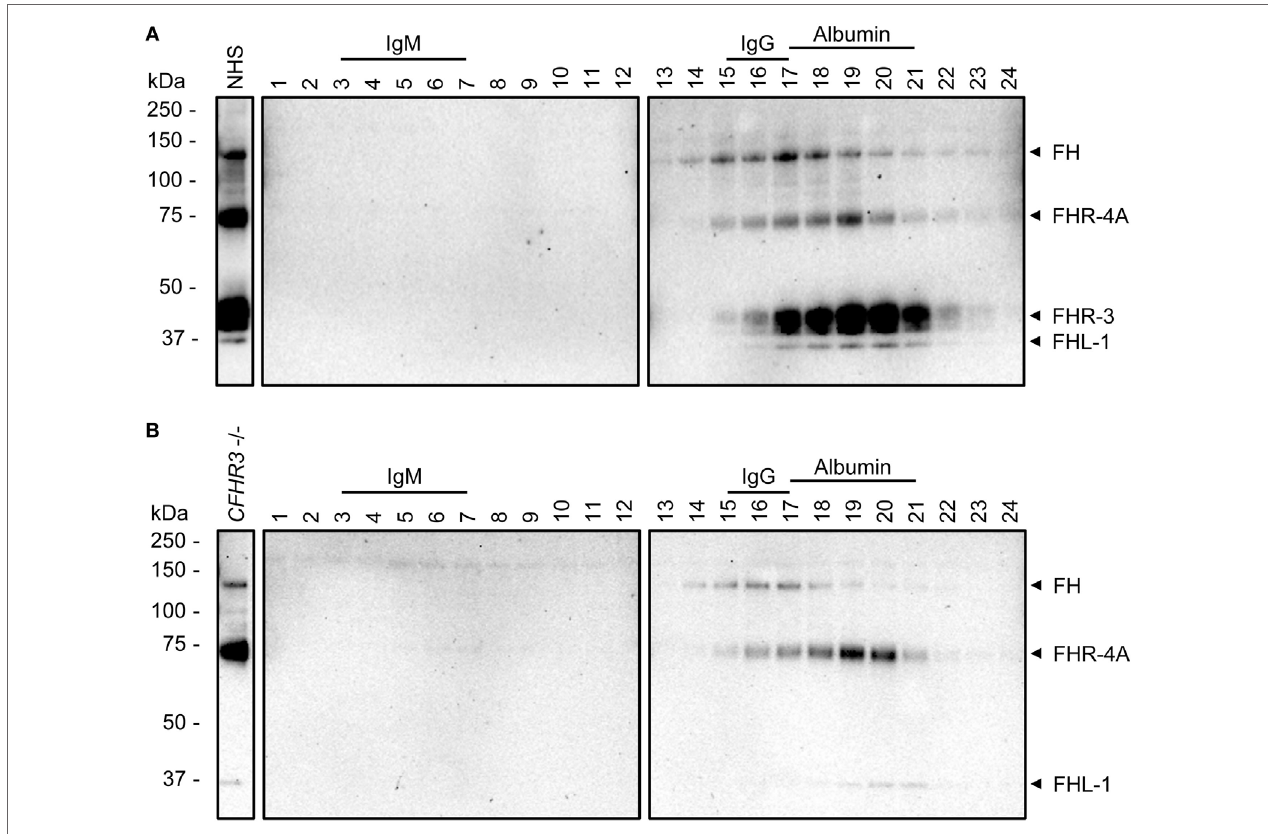
FigUre 3 | Sucrose gradients of normal human serum (NHS) and CFHR3- deficient serum. Western Blots of immunoprecipitation (IP) of fractions (1–24) from a sucrose gradient with (a) NHS or (B) a serum pool deficient for FHR-3 ( CFHR3 − / − ). IP was performed using anti-FHR-3.3, Western Blots were stained with biotinylated polyclonal anti-FHR-3 antibody. Fractions containing IgM (970 kDa, fractions 3–7), IgG (150 kDa, fractions 15–17), or albumin (66 kDa, fractions 17–21) are indicated above the blots and used as size reference. Identified proteins are indicated with arrowheads on the right